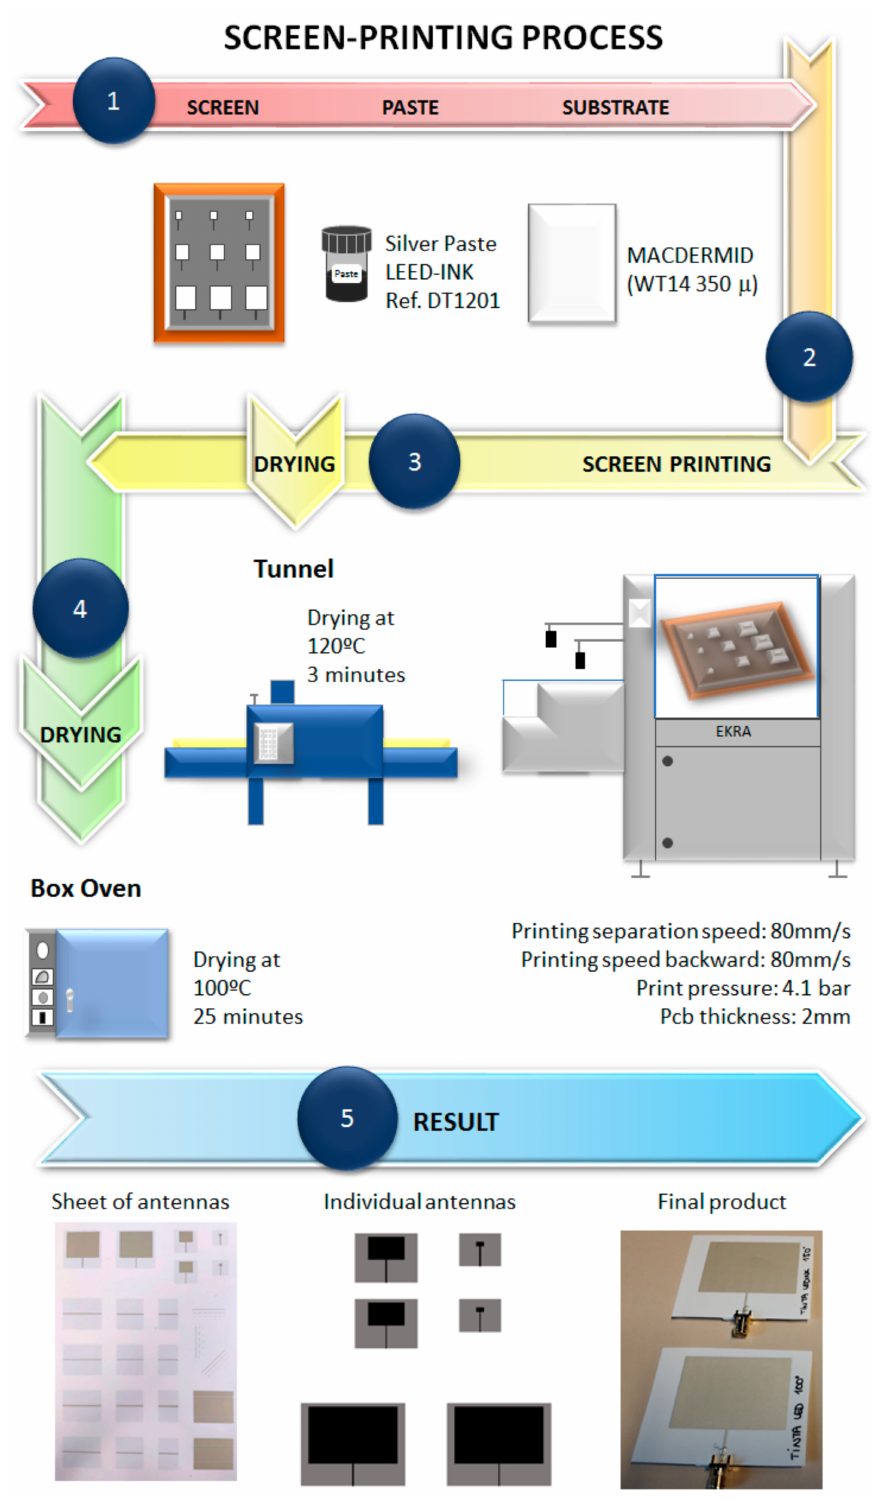
Figure 1. Schematic description of the fabrication of antenna prototypes based on the screen-printing process, divided into five steps: ( 1 ) material parameter election, ( 2 ) printing process, ( 3 ) tunnel drying, ( 4 ) oven drying, ( 5 ) sheet prototype and subsequent